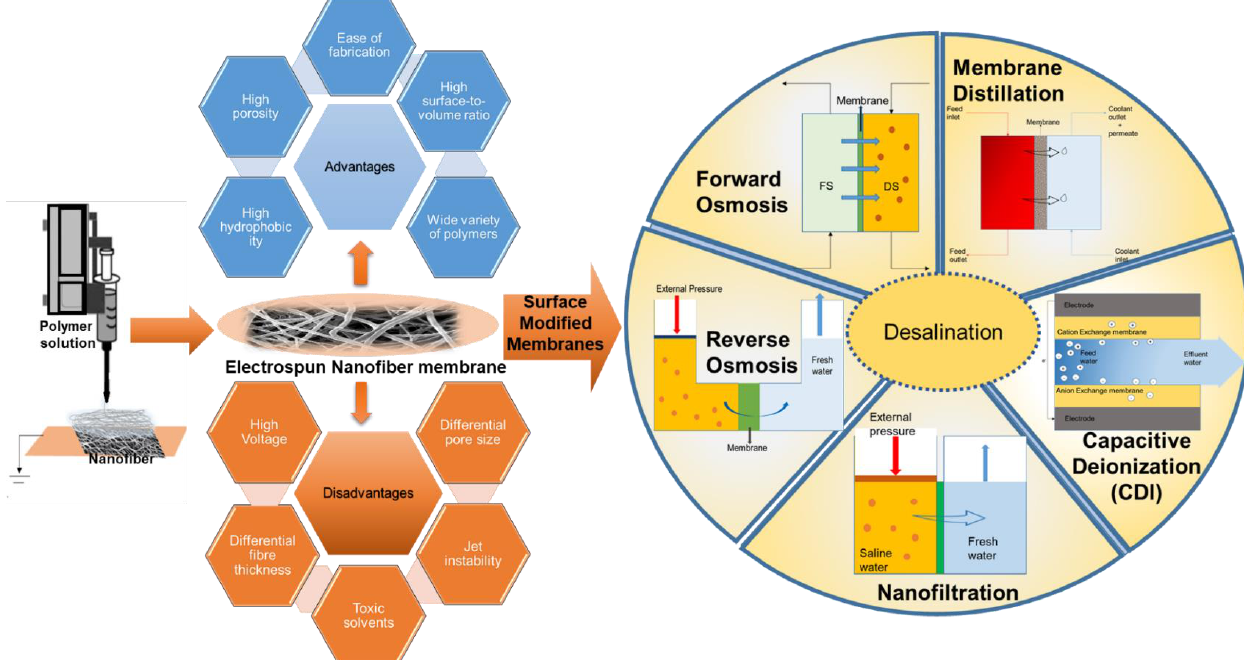
Figure 5. Nanofiber membrane advantages, disadvantages, and applications in desalination.